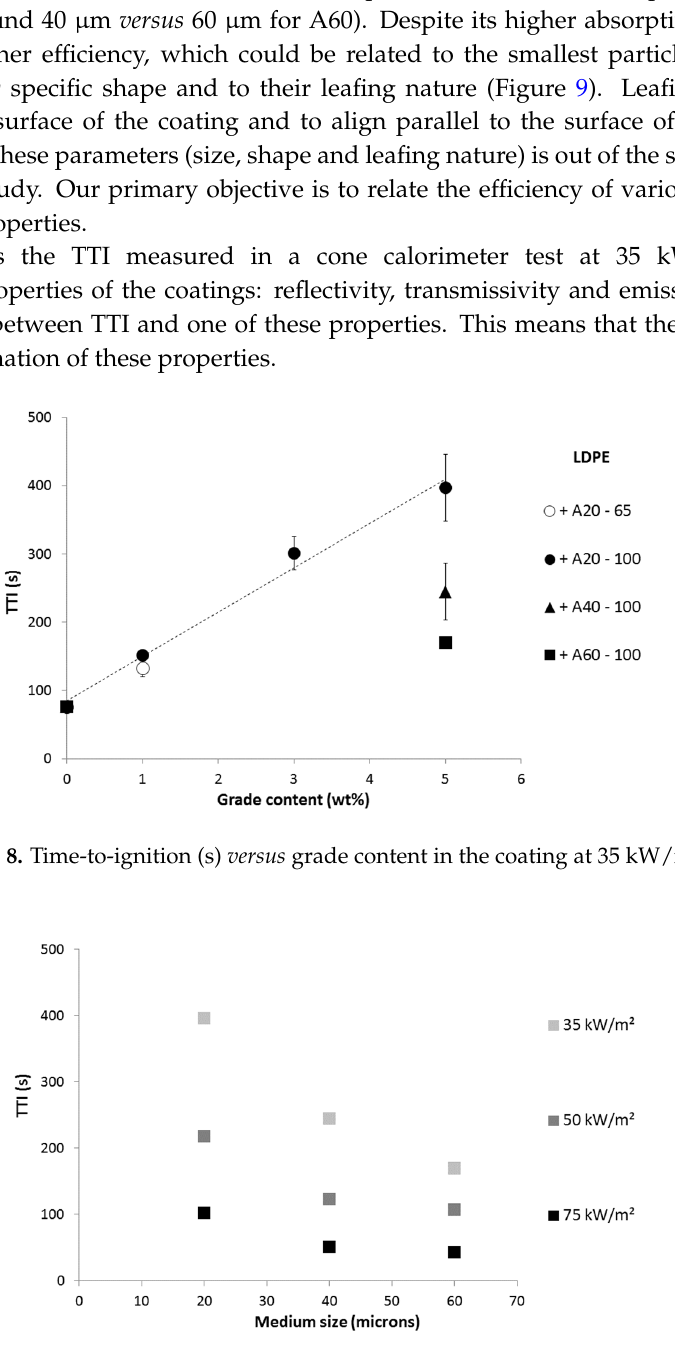
Figure 10. Time ‐ to ‐ gnition (s) at 35 kW/m 2 versus thermal ‐ radiative properties of the coatings.